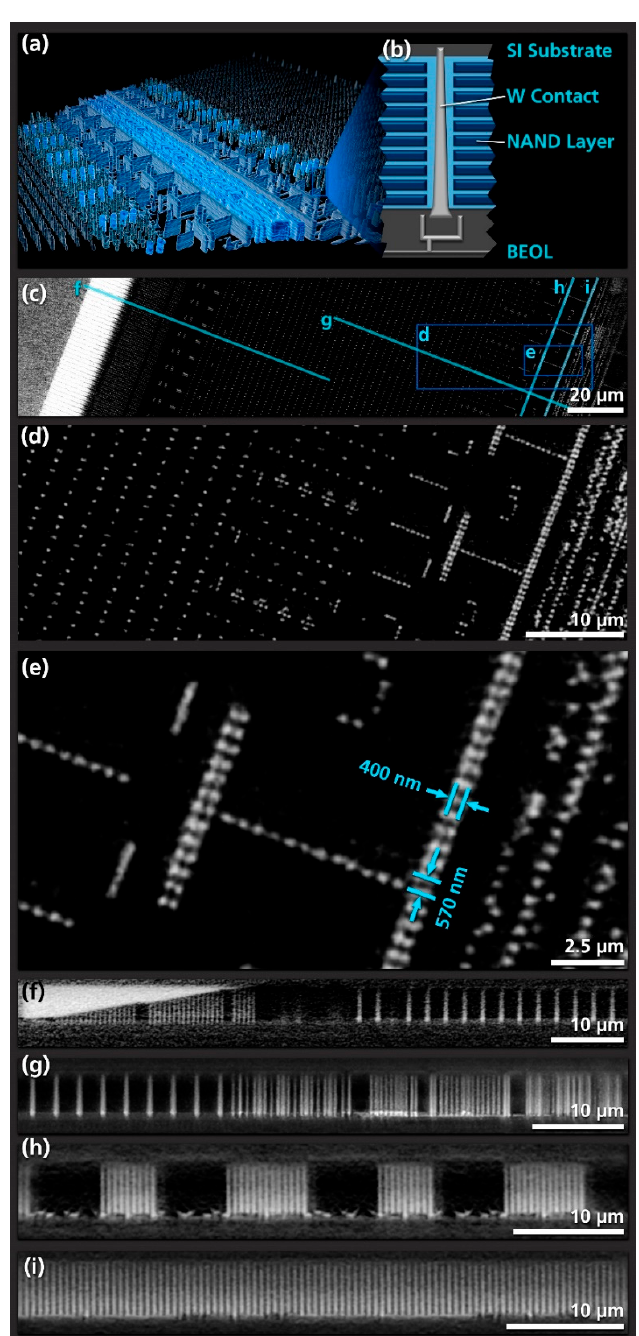
Figure 7. Reconstructed nano CT scan of a semiconductor memory chip from a commercial micro sd card (SanDisk 32 GB microSDHC UHS-I) measured with a sampling of 98 nm. ( a ) 3D rendering (All 3D visualizations shown in this study were carried out in Avizo 9.0—Thermo Fisher Scientific) of the internal metalized structures, where the individual contacts with an expected size between 100–200 nm can be clearly identified. ( b ) schematic of a single contact pillar connecting the multiple word lines. ( c ) volume cross-section from the reconstruction with a memory array in the center and a section of the peripheral circuits to the right. ( d , e ) enlarged details of the sectional view with dimensions for specific features, ( f – i ) vertical sections through the volume corresponding to the markings in ( c ). ( f ) word line staircase at the edge of the chip. ( h , i ) vertical view of the peripheral circuits.